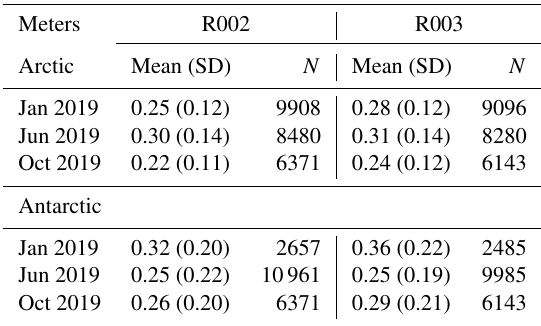
Table 1. Comparison of summary statistics and grid coverage of freeboard retrievals for the 3 months over the Arctic and Antarctic sea ice cover shown in Figs. 5 and 6. N is the number of grid cells (25km) with freeboard